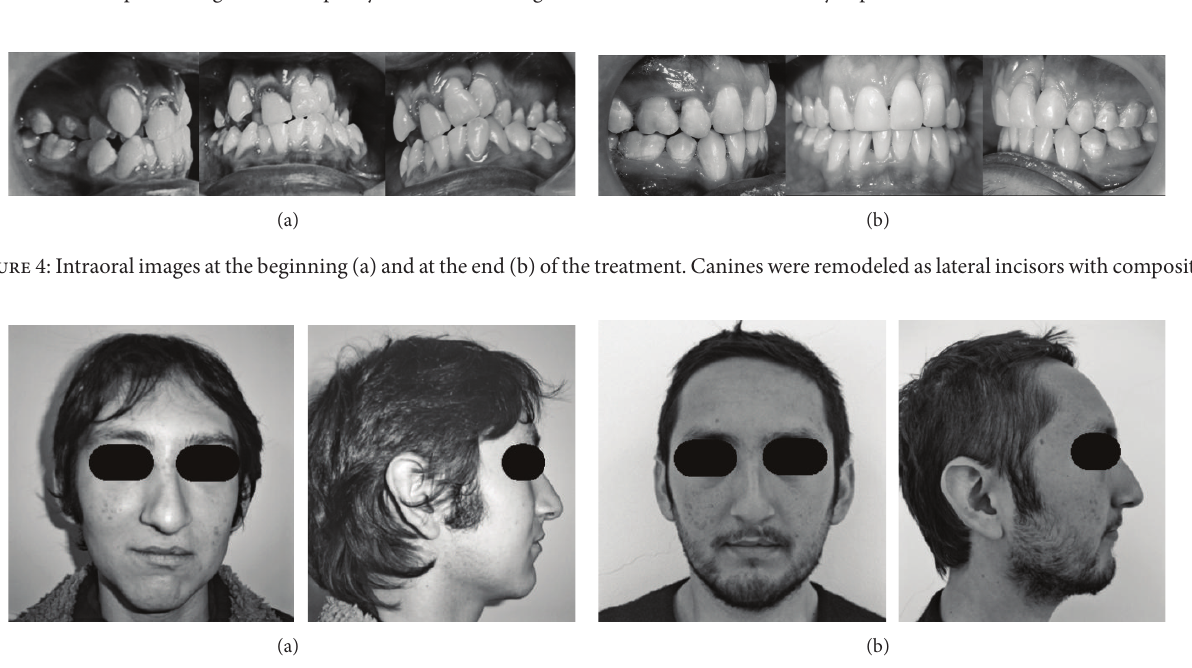
Figure 3: Dental cast at the beginning (a) and at the end (b) of the treatment. You can see the dental crowding in the maxilla, with the presence of 1.5 on the hard palate. Negative discrepancy was solved through extractions and slow maxillary expansion.